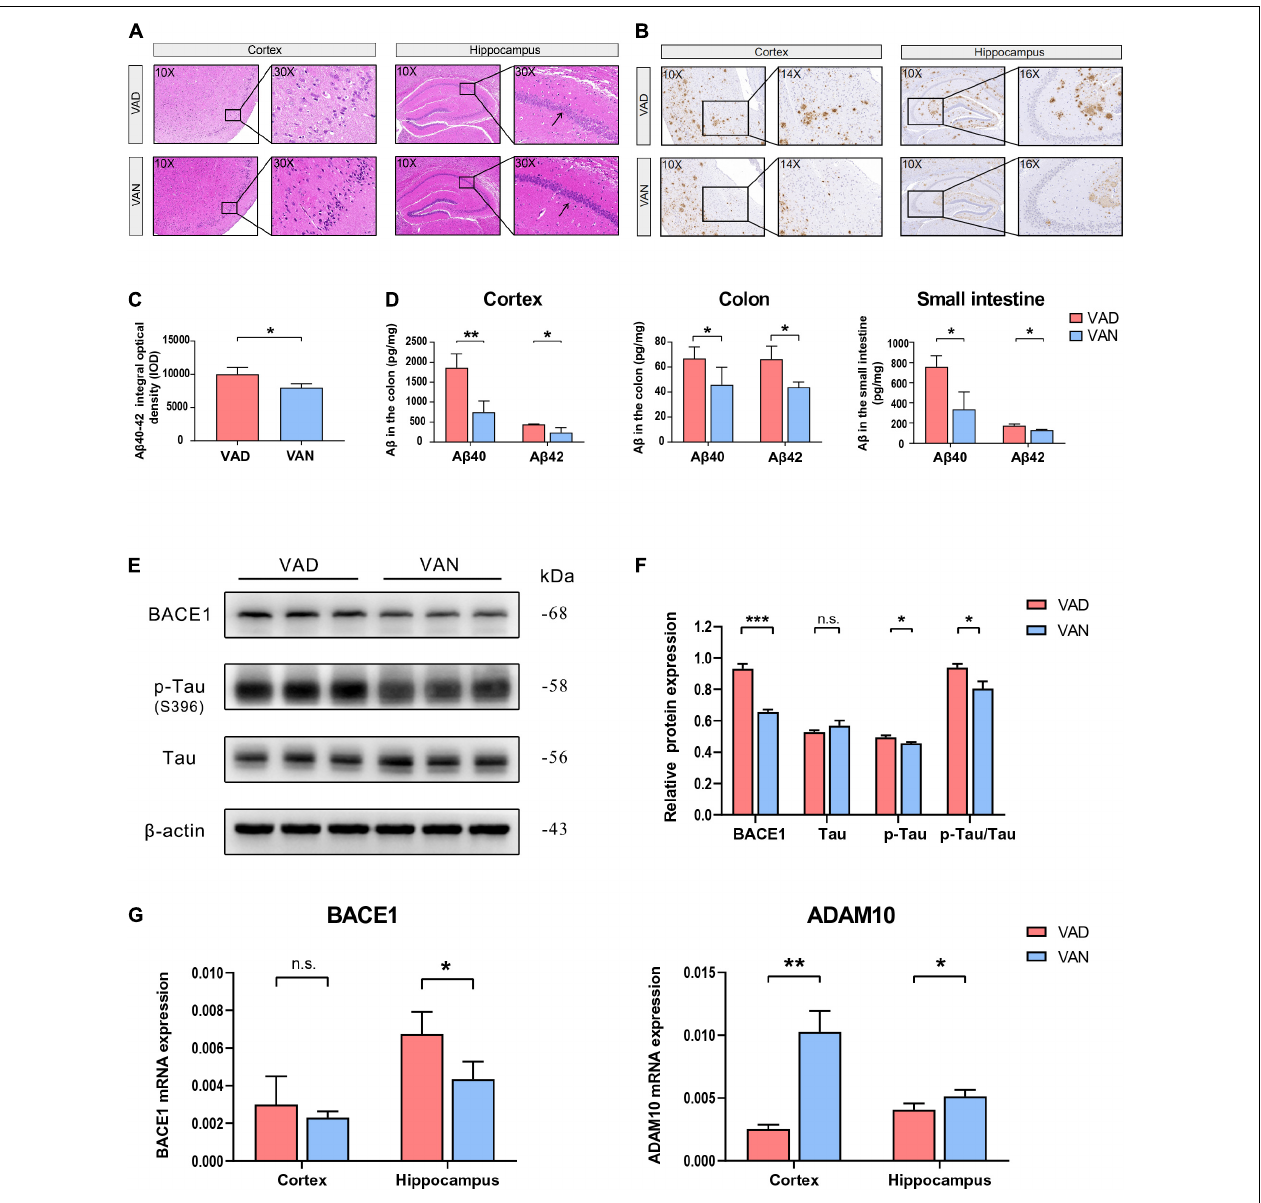
FIGURE 3 | Consumption of the VAD diet for 45 weeks exacerbated the AD-related pathological changes in the cortex, hippocampus, colon, and small intestine of the APP/PS1 transgenic mice. (A) Hematoxylin-Eosin (H&E) staining (10 × and 30 × ) in the brain of the APP/PS1 mice. (B) Immunohistochemistry (IHC) staining (10 × , 14 × , and 16 × ) of A β 40 and A β 42 depositions in the brain of the APP/PS1 mice. The primary antibody used for IHC staining could specifically bind both the A β 40 and A β 42. (C) Quantification of the IHC staining of the A β 40 and A β 42 depositions in the cortex of the APP/PS1 mice. (D) The A β 40 and A β 42 concentrations in the cortex, colon, and small intestine as determined by the Luminex immunoassay. The Luminex immunoassay can detect the concentration of A β 40 and A β 42, respectively. (E) Western blot (WB) images showing the level of BACE1, Tau proteins, and the phosphorylated Tau (p-Tau, S396) protein in the cortex of the APP/PS1 mice. (F) Quantification of the WB result showing the relative level of BACE1, Tau, p-Tau, and the ratio of p-Tau toTau. (G) The RT-qPCR result showing the mRNA level of the BACE1 and ADAM10 genes in the cortex and hippocampus of the APP/PS1 mice. VAD, vitamin A deficiency diet; VAN, vitamin A normal diet. n = 3